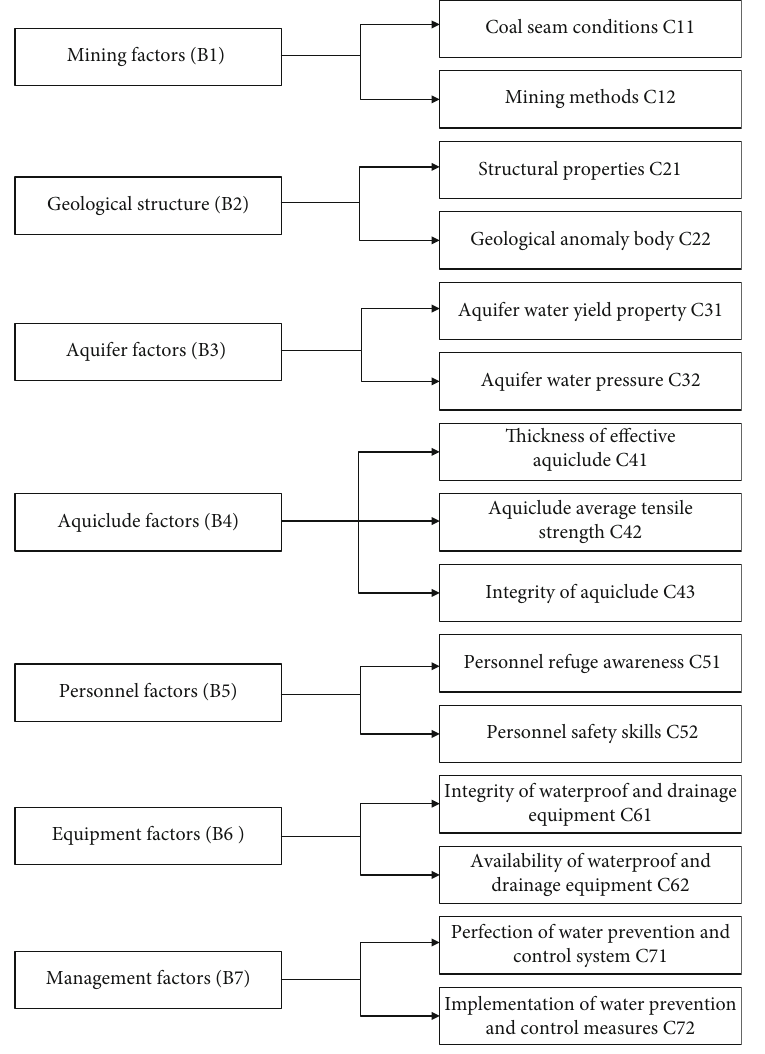
Figure 2: Risk assessment indicator system of coal fl oor